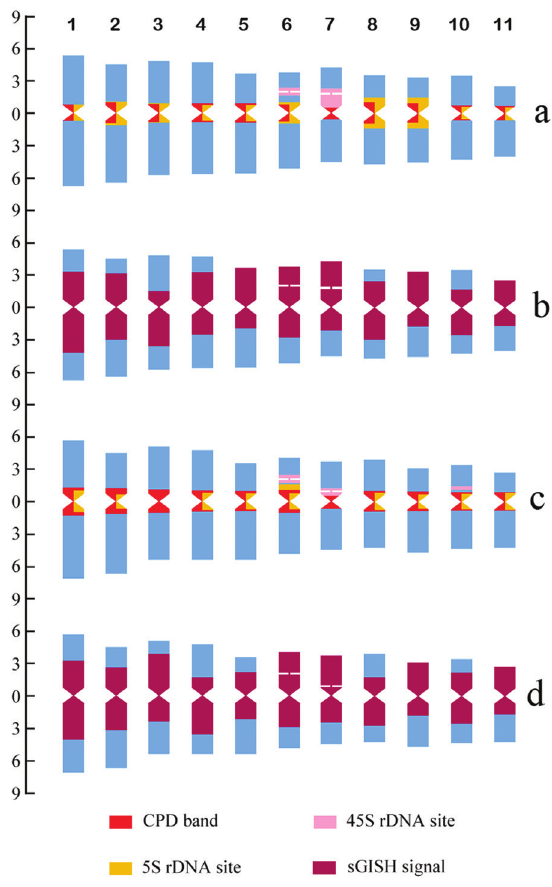
Figure 3. Idiograms of Canavalia gladiata ( a, b ) and C. ensiformis ( c, d ). a and c are idiograms display- ing chromosome measurements and position and size of fluorochrome bands and rDNA FISH signals, b and d are idiograms displaying chromosome measurements and size and distribution of sGISH signals. Ordinate scale on left indicates relative chromosome length (% of haploid complement). The numbers above panel a are chromosome